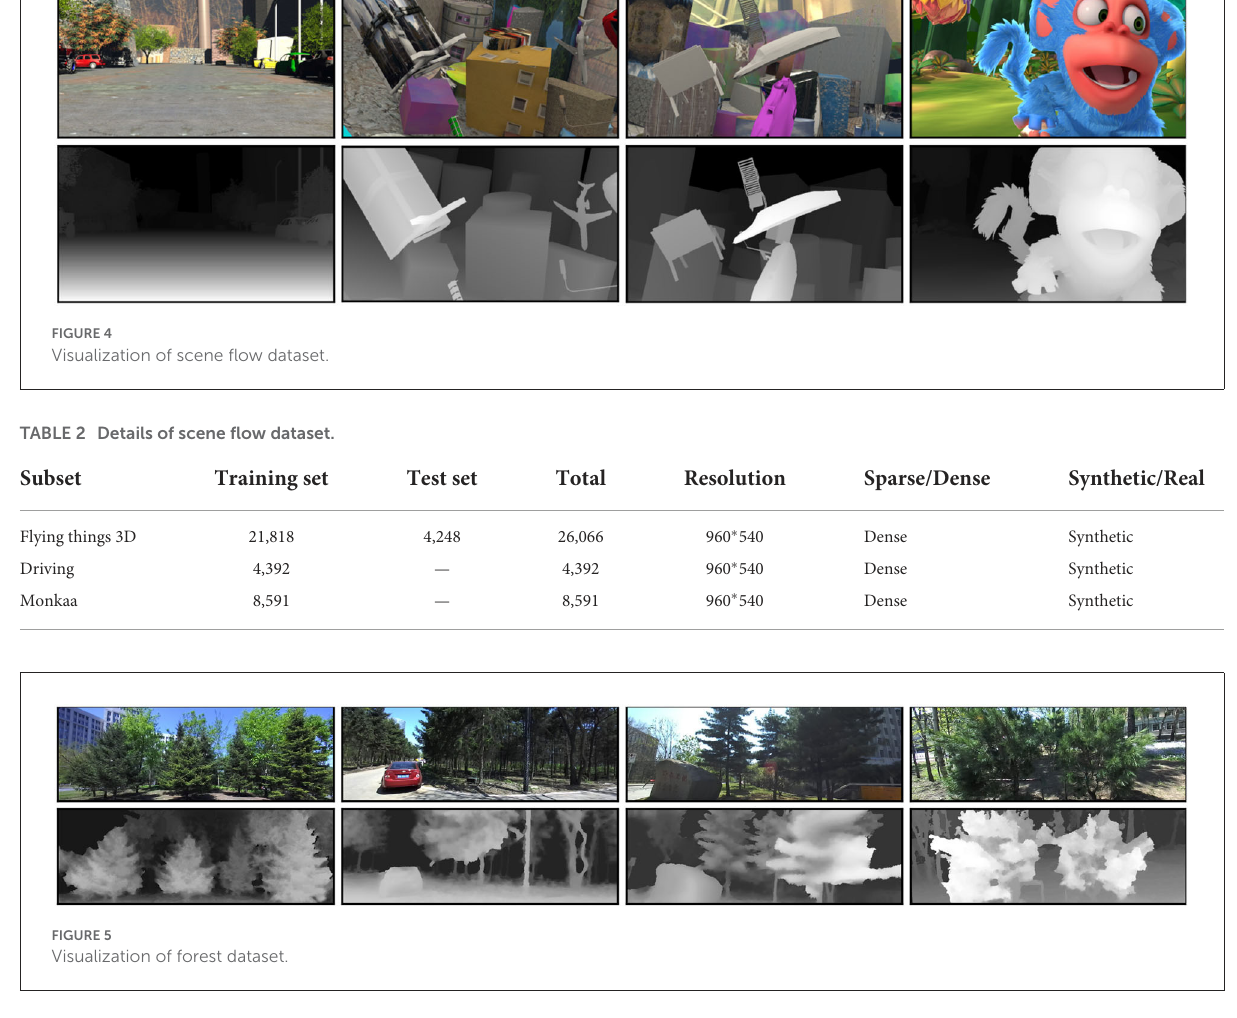
TABLE 3 Layers and parameter settings of the proposed LANet. Variety Training